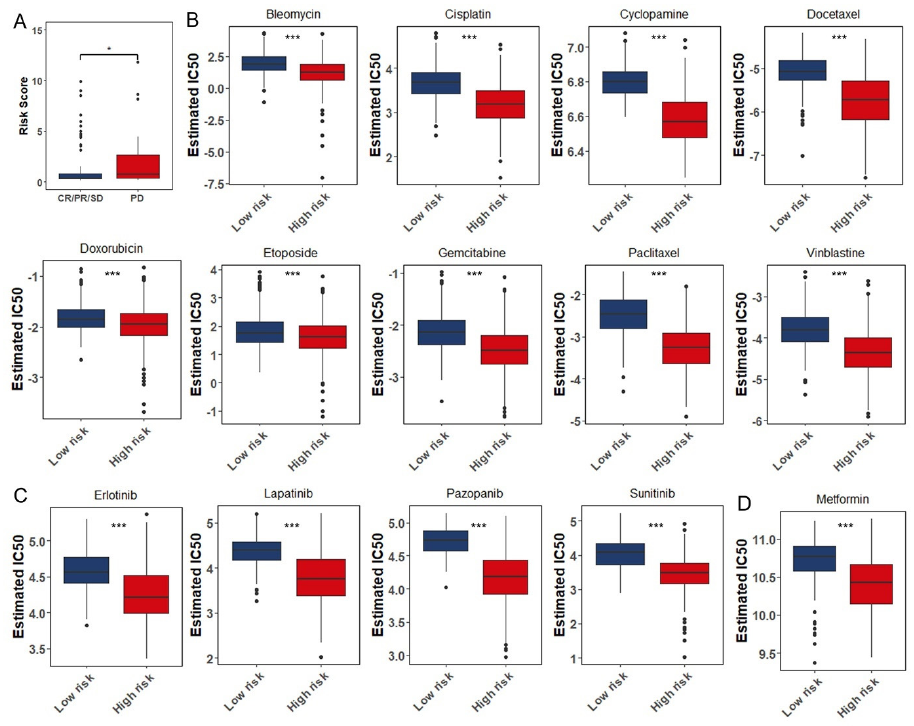
Figure 9. The role of the eight immune-related RBPs signature in predicting the sensitivity to chemotherapeutic agents: ( A ) The risk score of each group was calculated and verified to be statistically significant between effective group ( n = 100, CR: complete response; PR: partial response; SD: stable disease) and ineffective group ( n = 31, PD: progressive disease). ( B ) The box plots of the estimated IC 50 for Bleomycin, Cisplatin, Cyclopamine, Docetaxel, Doxorubicin, Etoposide, Gemcitabine, Paclitaxel, and Vinblastine. ( C ) The box plots of the estimated IC 50 for Erlotinib, Lapatinib, Pazopanib, and Sunitinib. ( D ) The box plot of the estimated IC 50 for Metformin. Low risk ( n = 346); High risk ( n = 345); *, p < 0.05; ***, p < 0.001.